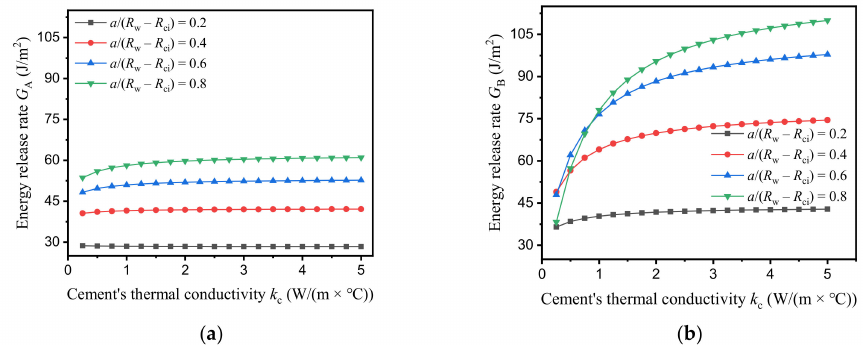
Figure 11. Evolution of the energy release rate at the radial crack tips with cement’s thermal expansion coe ffi cient: ( a ) crack tip A; ( b ) crack tip